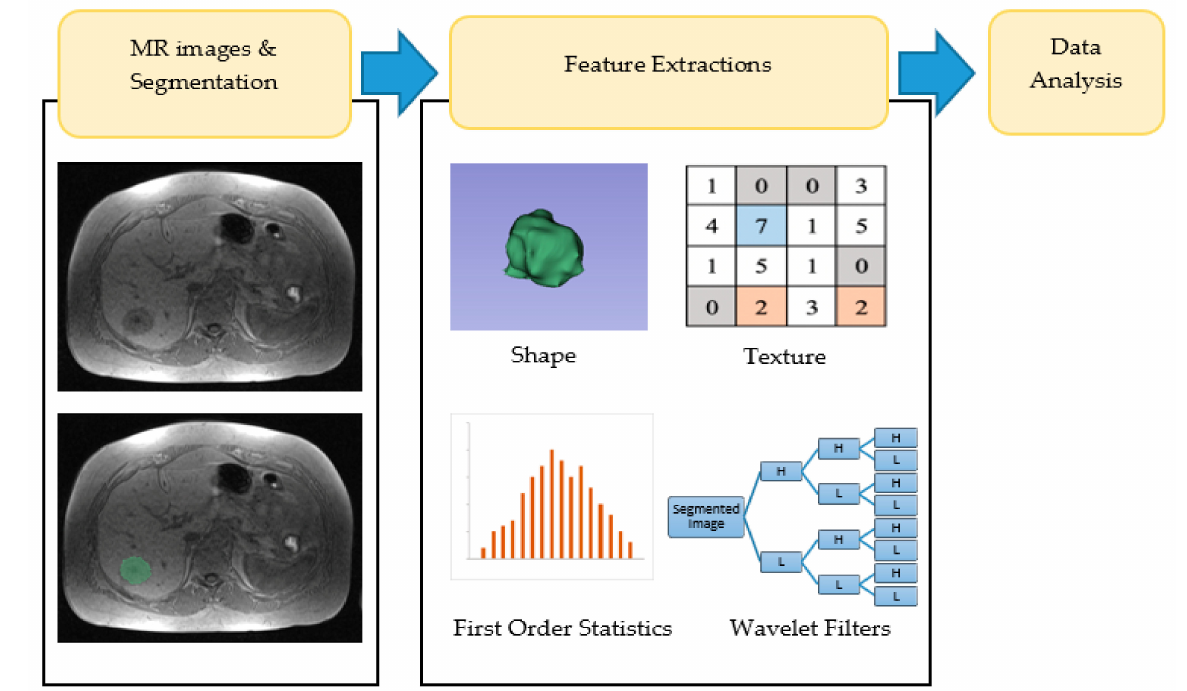
Figure 1. Schematic diagram of the